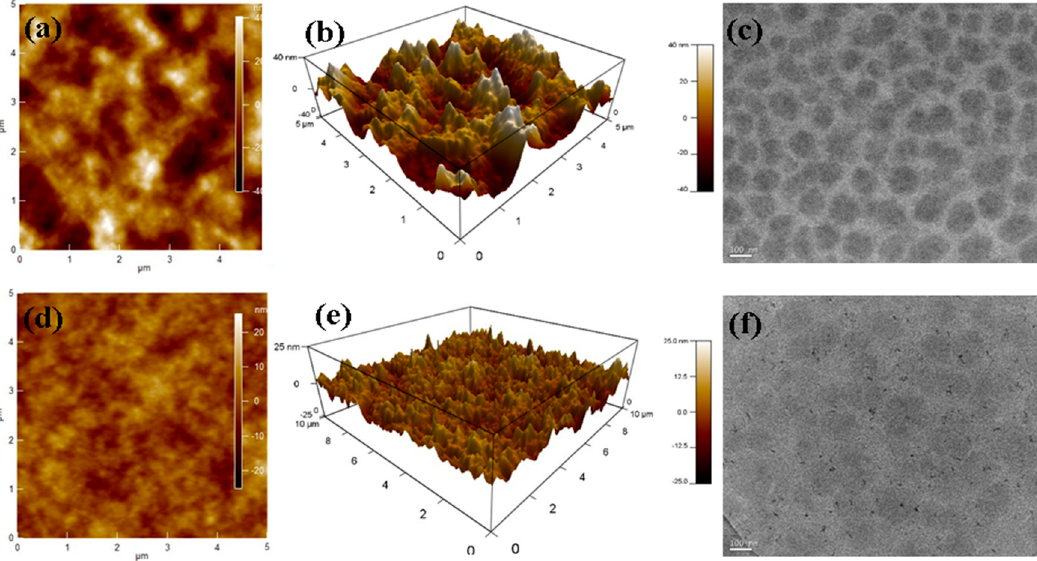
/ PC 71 BM blend films: ( a , d ) AFM height; ( b , e ) 3D